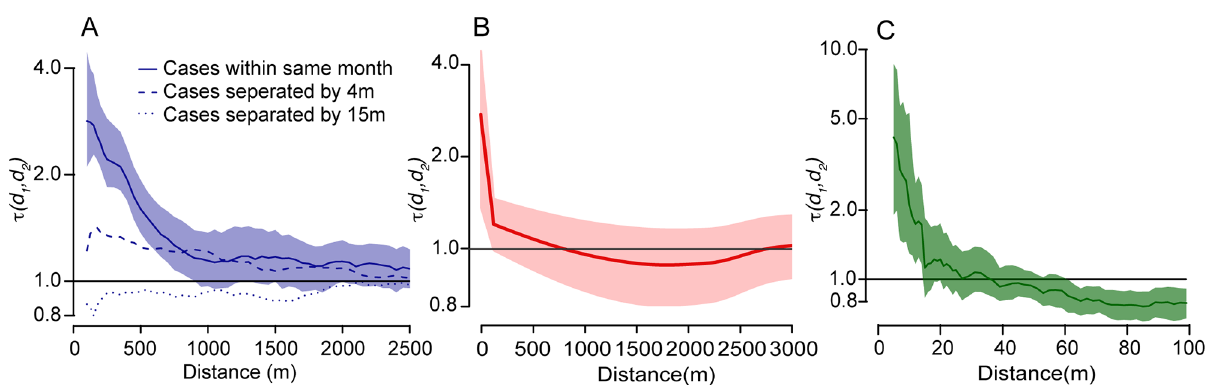
Fig 4. (A) τ -statistic results from 1,912 dengue cases that presented at a Bangkok hospital between 1995 and 1999. The solid line represents the probability of cases occurring within the same month being of the same serotype, relative to any two cases being of the same serotype and occurring within the same month. The dashed line is the same analysis but with a temporal lag of four months and the dotted line are the results using a temporal lag of 15 months. Confidence intervals for the temporal lags of four months and 15 months are presented in S1 Fig. (B) Smoothed τ -statistic of HIV incident to HIV prevalent individuals in Rakai Uganda. The τ -statistic is calculated within households (i.e, at 0m) and in a sliding 250m window up to the average distance between community households, 3.3km. (C) τ - statistic results from 188 measles cases from Hagelloch, Germany in 1861 – 1862. The τ -statistic is calculated using a sliding 50m window and compares the risk of observing cases at that distance range for individuals sick within two weeks of each other to all